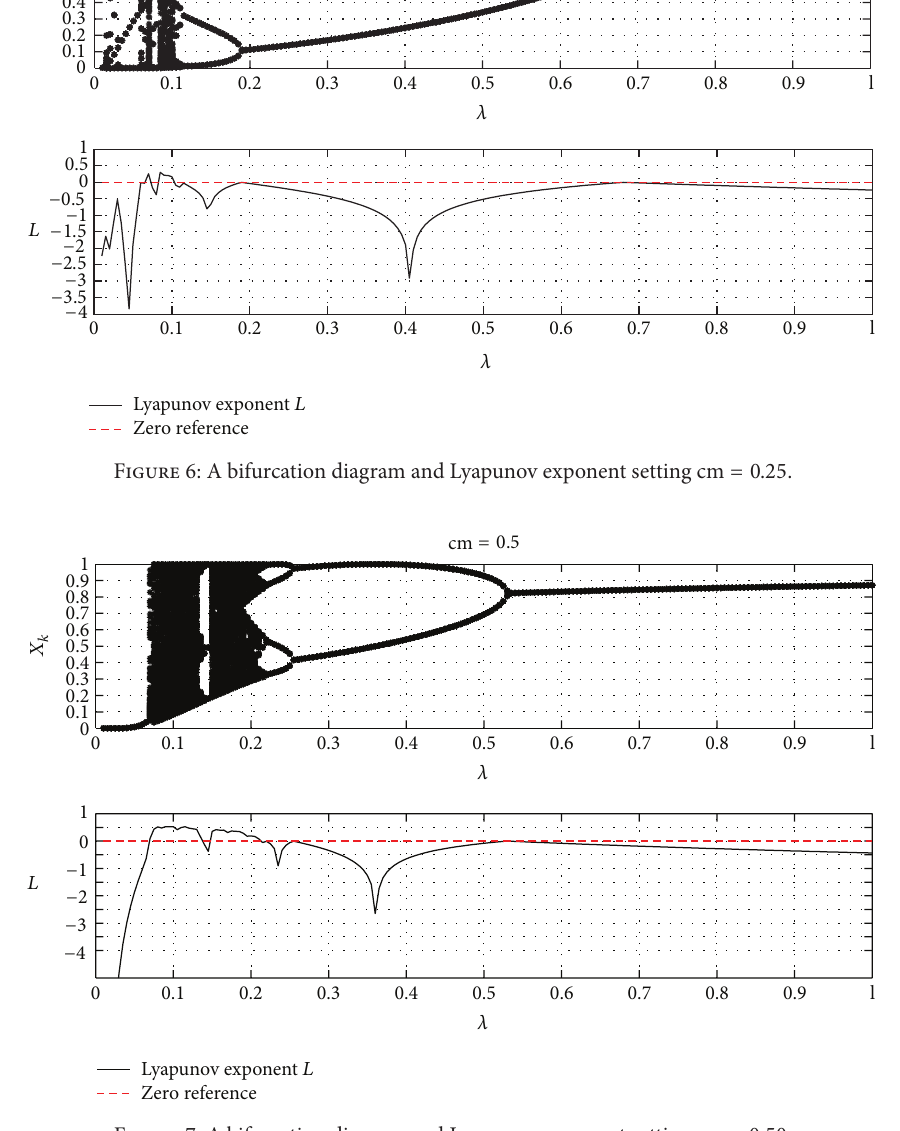
Figure 7: A bifurcation diagram and Lyapunov exponent setting cm = 0.50